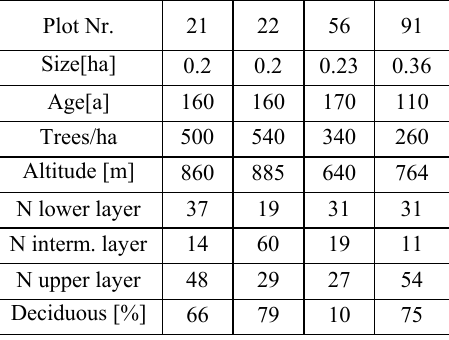
Table 1. Characteristics of sample plots